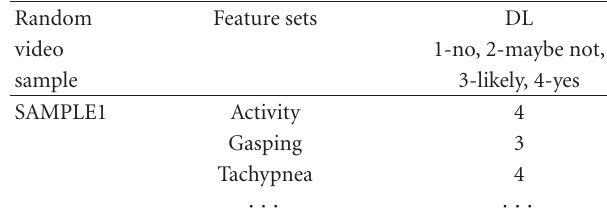
Table 1: Evaluation template to measure the bit rate at which DL quality is